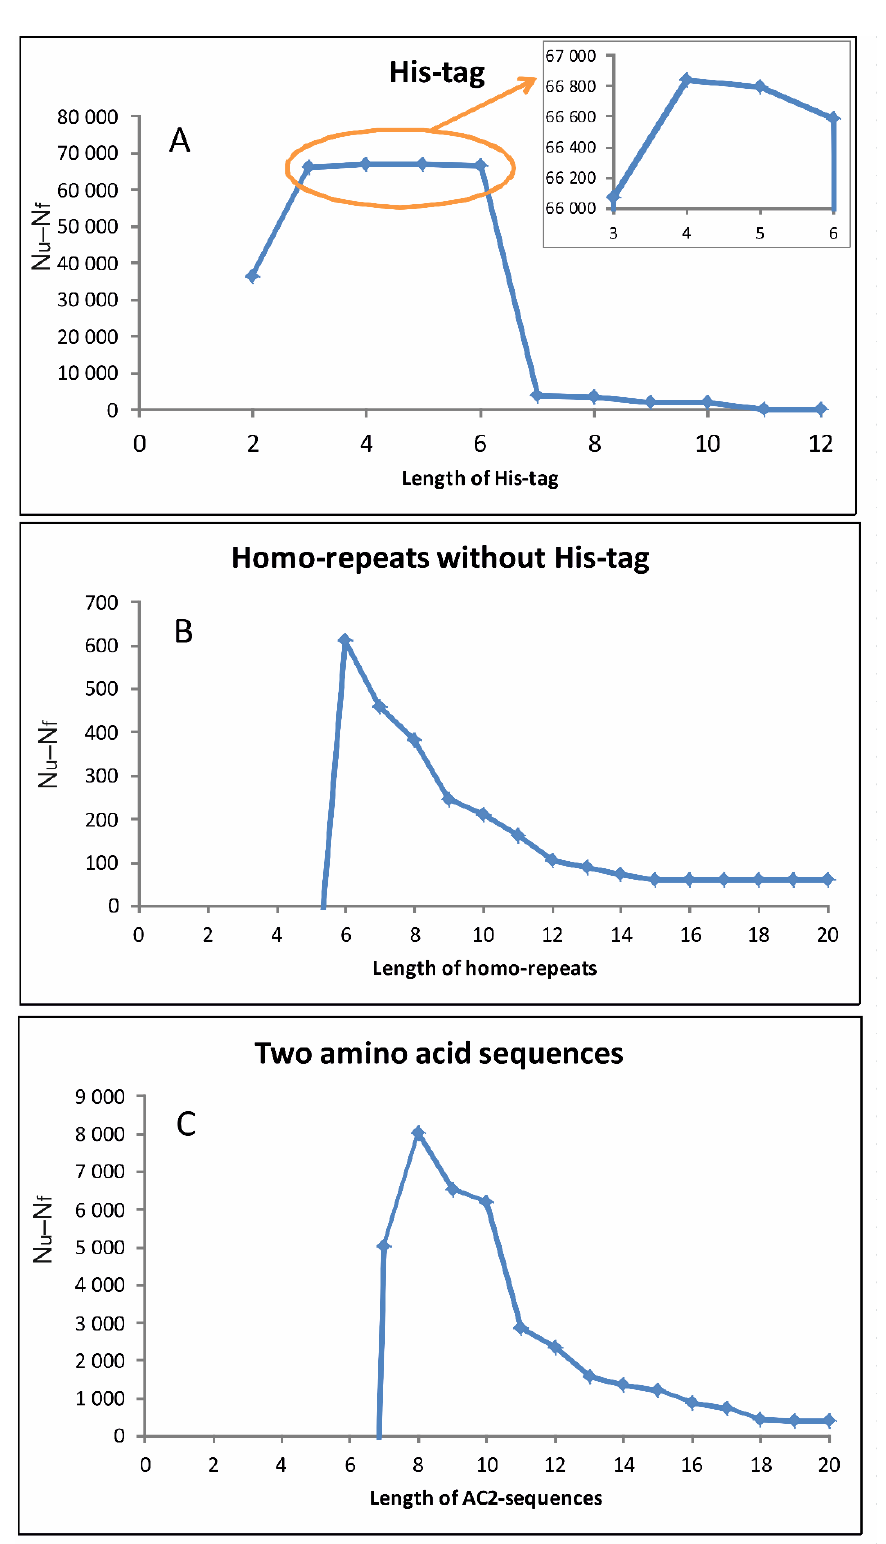
Figure 2. Dependence of the difference in the number of disordered and ordered residues in sequences covered by the patterns on the length of the last: ( A ) histidine tags, ( B ) homo-repeats, and ( C ) AC2-sequences in the clustered PDB.